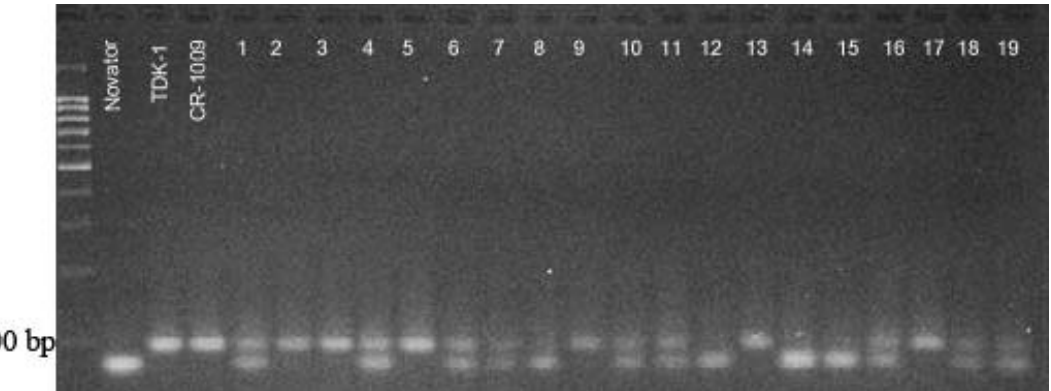
Figure 8. Electrophoregram of the amplification products of rice genomic DNA with the primer RM 4781. 1–19, F 2 (Novator × CR-1009); TDK-1 and CR-1009, donor of the Sub1A gene. Molecular weight marker, 1 kb.